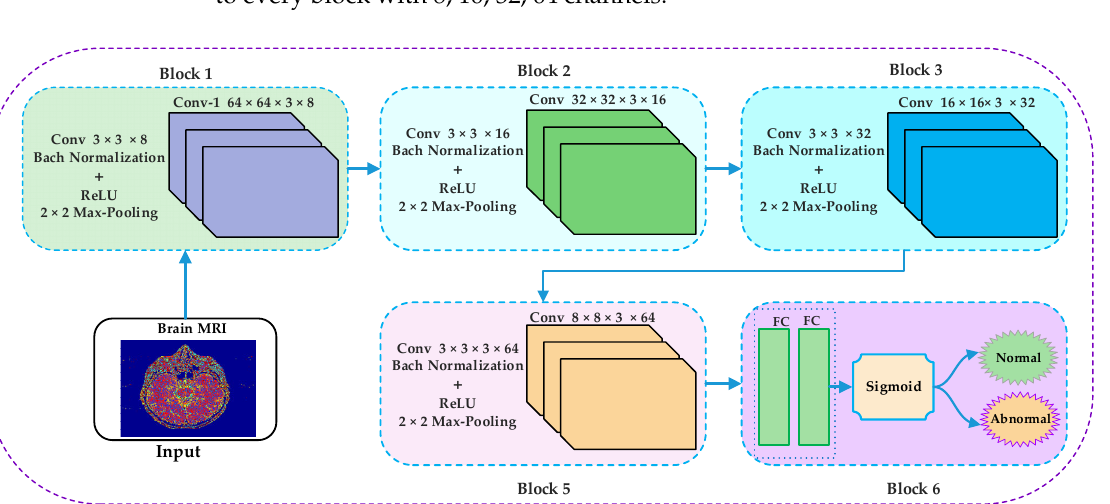
Figure 4. Proposed schematic CNN diagram for classification of brain MRI as normal and abnormal. The block ‐ wise architecture of the proposed model is illustrated in Figure 5. The kernel size of convolutional layers in the first four blocks is represented using Equation (5). where h , w , and c represent the height, width, and channel, respectively. The h = w = 3 in the first four blocks, c = 8 in the first block, c = 16 in the second block, c = 32 in the third block, and c = 64 in the fourth block of the proposed model of CNN. A 2 × 2 max ‐ pooling has been used in the first four blocks with stride = 2. Bach normalization has been applied to every block with 8, 16, 32, 64 channels.